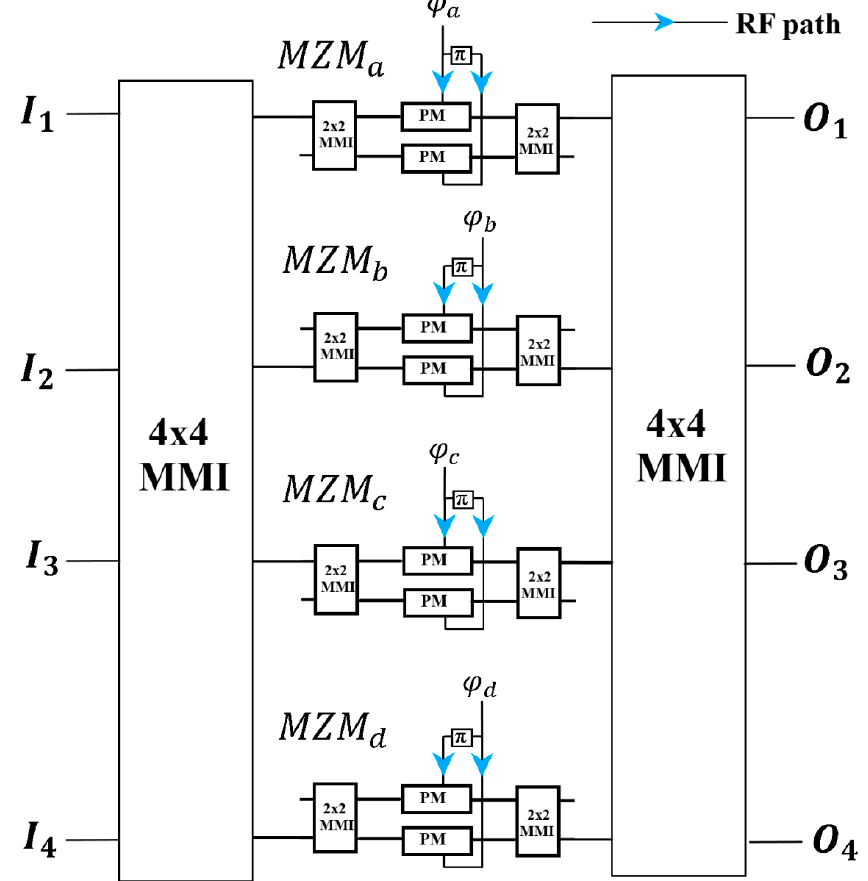
Figure 2. Schematic diagram of the photonics frequency shifter circuit. Each MZM is driven differentially with modulating signals ϕ a , ϕ b , ϕ c and ϕ d , respectively. PM, phase modulator; MMI, multimode interference coupler.